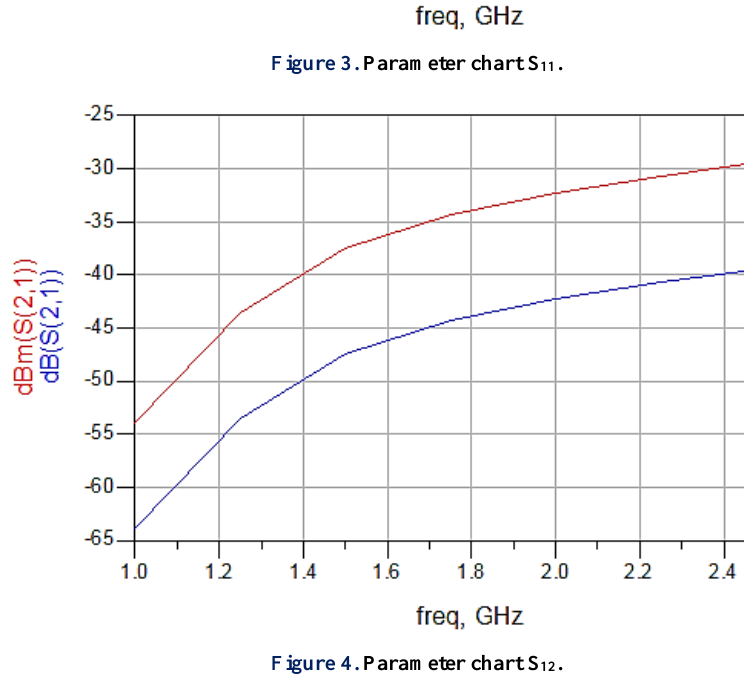
Figure 4. Parameter chart S 12 .